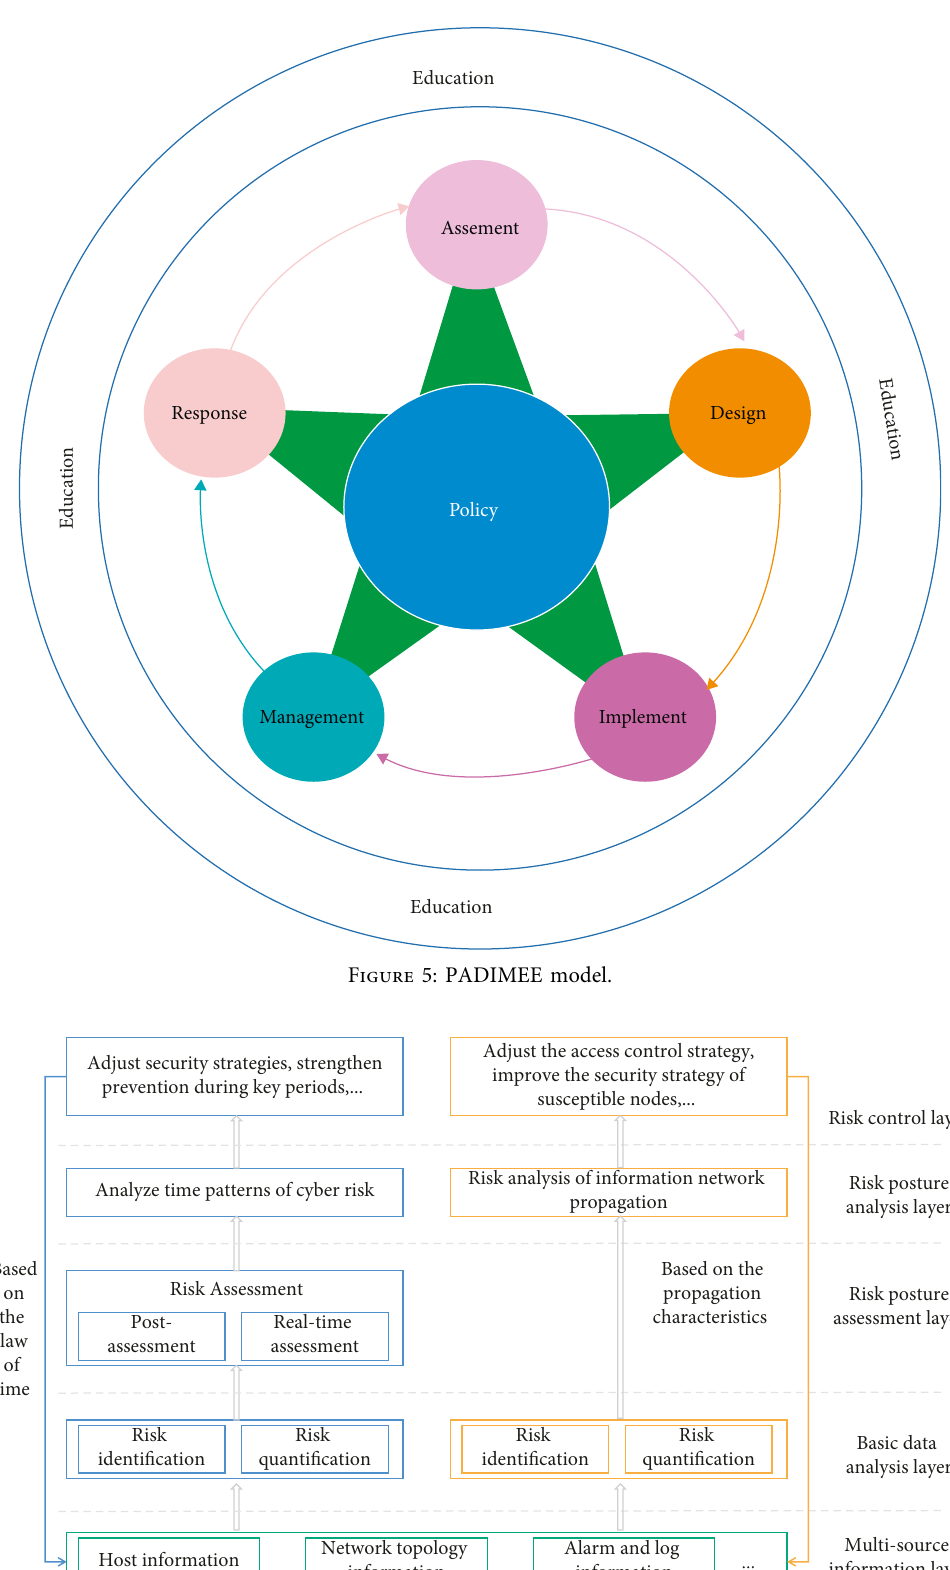
Figure 6: Framework structure of the information security risk multidimensional dynamic management